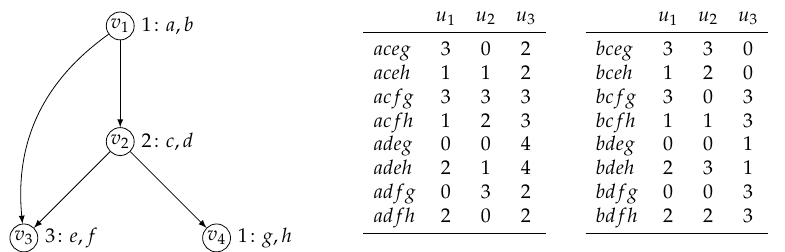
Figure 10. The partial order game from Example 1 with a slightly different utility function.